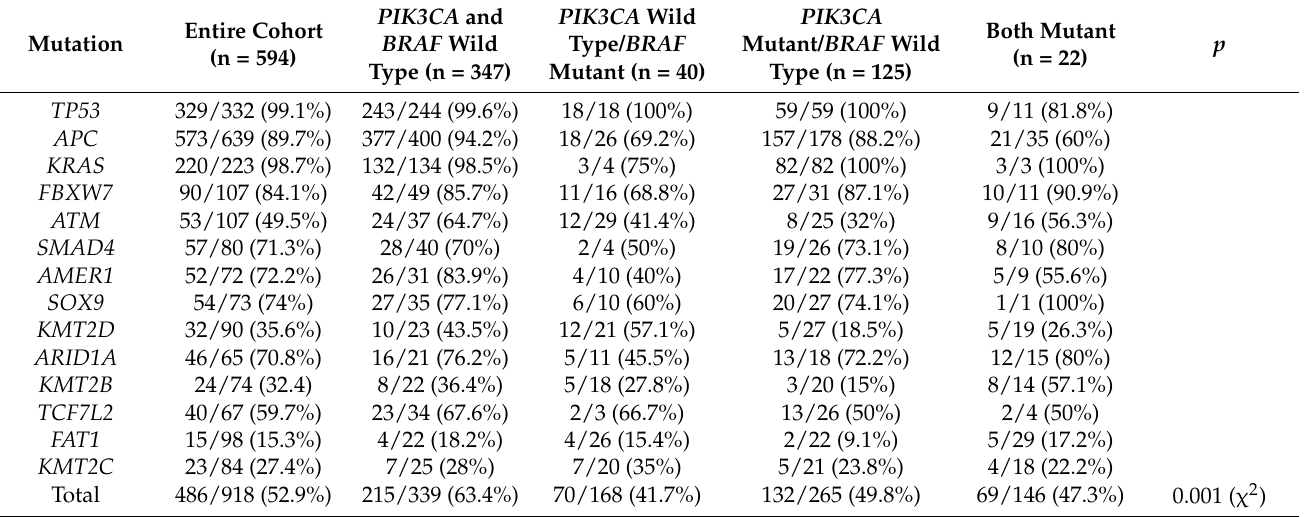
Table 5. Prevalence of functionally annotated mutations as oncogenic/probably oncogenic in com- monly mutated (more than 10% of cases in the whole cohort) cancer-associated genes in TCGA. The nominator in each case represents number of oncogenic or probably oncogenic mutations and the denominator represents the total number of mutations of each gene in each